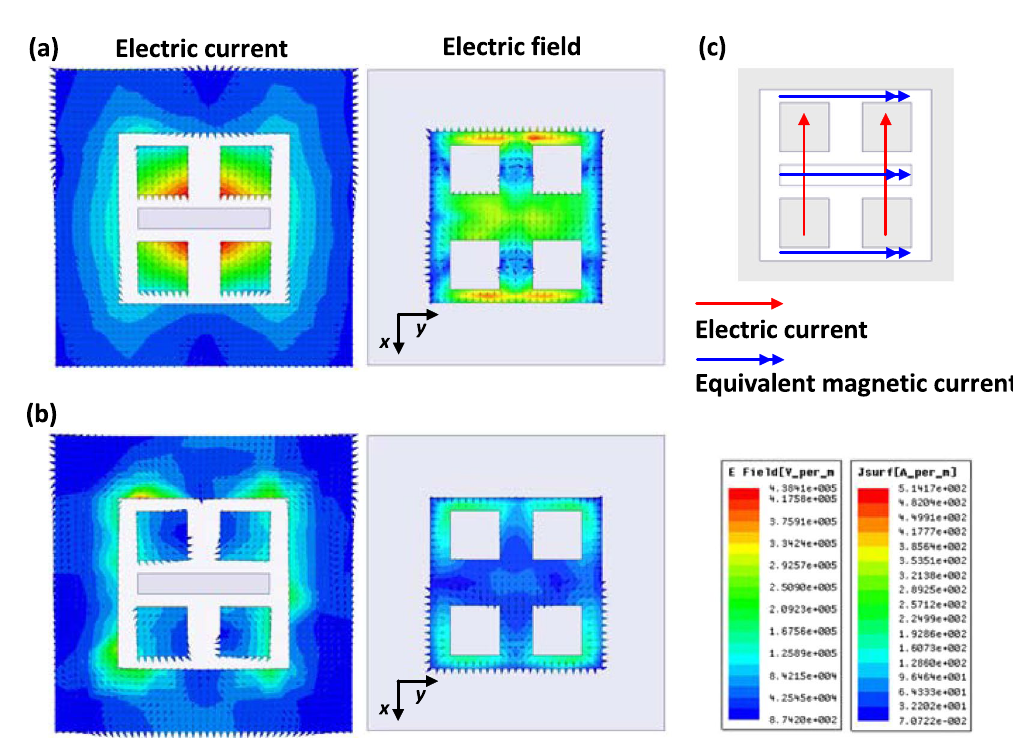
Figure 2. Simulated electric current and field distributions over the radiating aperture of the proposed antenna element. ( a ) The distributions at t = 0, ( b ) the distributions at t = T/4 where T is the period at 1 THz, and ( c ) radiation mechanism of the antenna